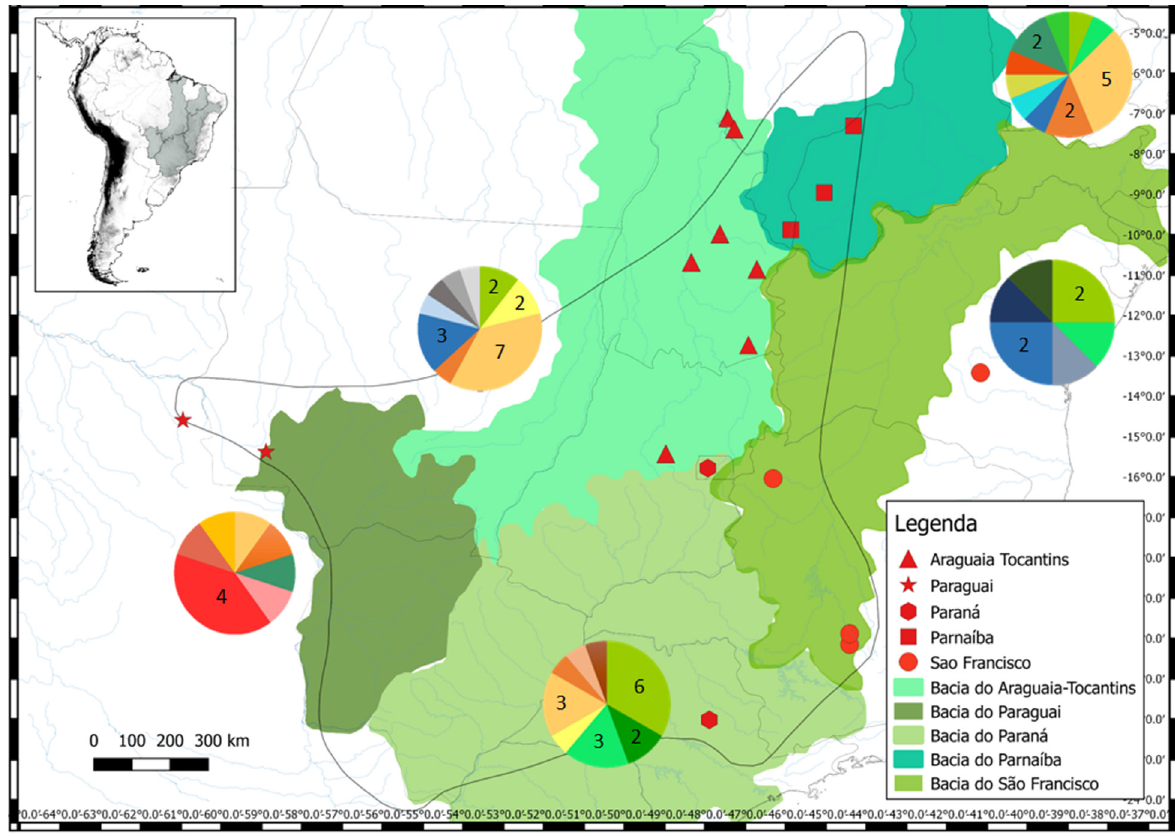
Figure 1. The five principal hydrographic basins of the Cerrado domain. The geographic distribution of Antilophia galeata (black line) and the sampling points are differentiated by hydrographic basin. The map of each basin shows the distribution of the haplotypes of Hypervariable Domain I of the mitochondrial Control Region. Each haplotype is represented by a distinct color and the numbers indicate the quantity of specimens that had the respective